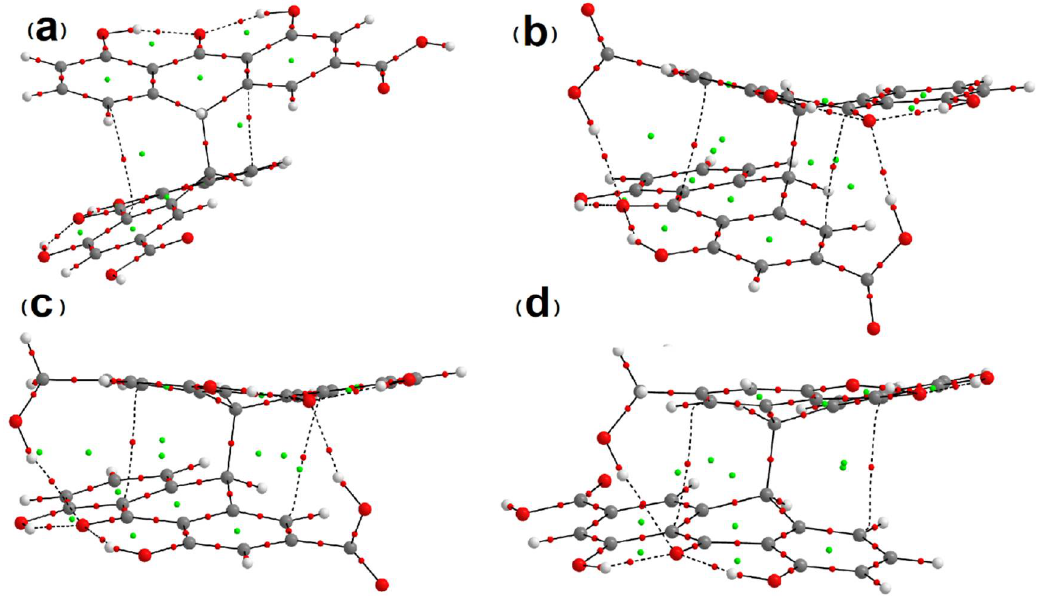
Figure 6. QTAIM plots for ( a )—1, ( b )—4, ( c )—14, ( d )—17 sennidin structures. Green points correspond to RCPs. Red points indicate BCPs.